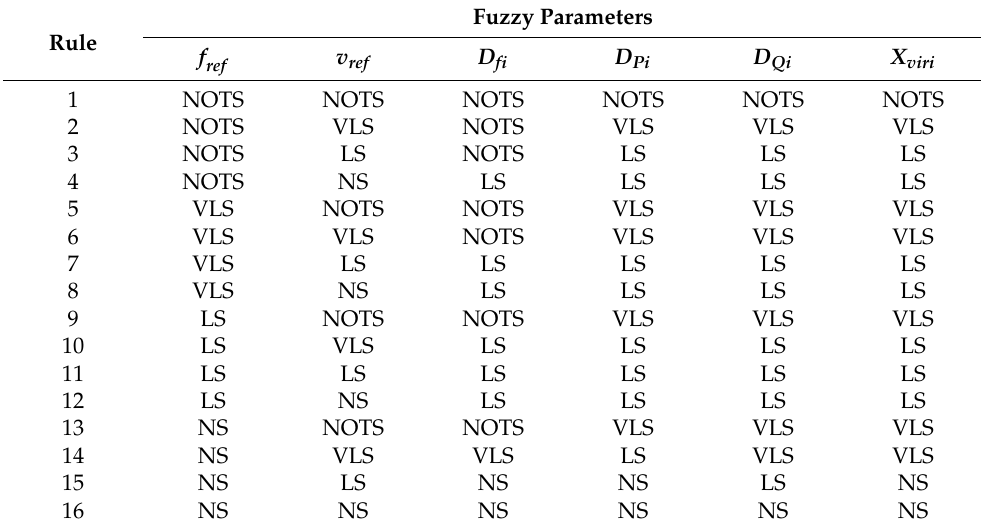
Table A1. Fuzzy rule set for inputs and outputs.